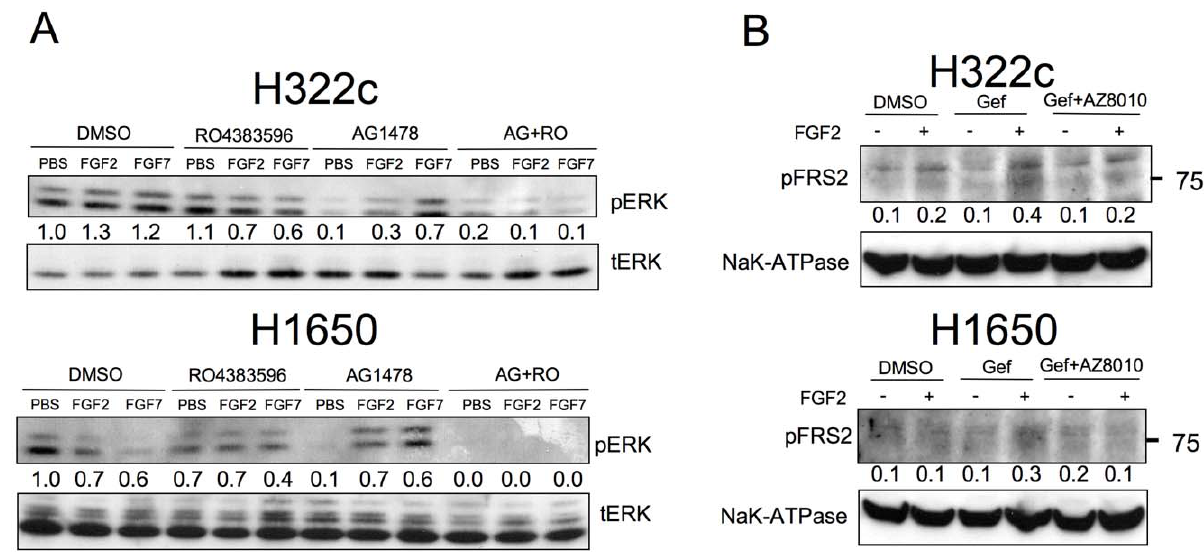
Figure 3. FGF-stimulated ERK and FRS2- a activation following EGFR TKI treatment. A. NSCLC cell lines were incubated with the EGFR inhibitor, AG1478 (0.1 m M) or DMSO, for 3 days in full media. Cells were switched to HITES for 2 hrs and subsequently incubated with the FGFR inhibitor, RO4383596 (1 m M) or DMSO for 1 hour followed by FGF2 or FGF7 stimulation at 10 ng/mL for 15 minutes. Extracts were prepared, resolved on SDS-PAGE and immunoblotted for phospho-ERK. The filters were subsequently stripped and reprobed for total ERK1 and ERK2 to verify equal loading. Densitometry of phospho-ERK2 relative to total ERK2 for the designated experiment is indicated. The mean and SEM of replicate experiments is indicated in the text of the Results section. B. NSCLC cell lines were incubated with the EGFR inhibitor, gefitinib (1 m M), gefitinib in combination with FGFR inhibitor AZ12908010, or DMSO for 3 days in full media. Cells were then stimulated with PBS or FGF2 at 10 ng/mL for 15 minutes. Extracts were prepared, resolved on SDS-PAGE and immunoblotted for phopho-FRS2. The filters were subsequently stripped and reprobed for NaK-ATPase a -